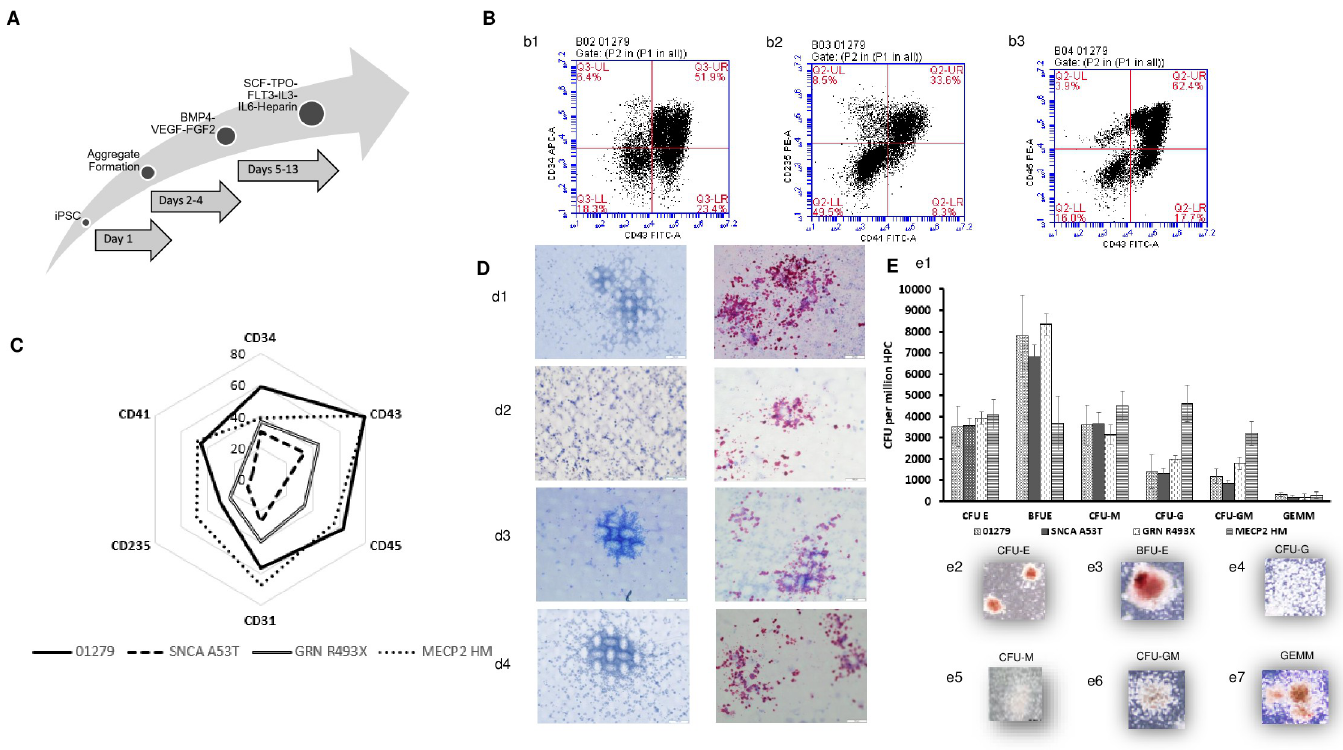
Fig 2. Generation and characterization of HPCs from isogenic iPSCs for disease modelling. (A) A schematic representation of the differentiation process from iPSC to HPC with the timeline and cytokines utilized throughout the process. (B) Representative flow cytometry dot plots for the HPCs’ (b1) lymphoid, (b2) erythroid, and (b3) myeloid potential from 01279 iPSCs. (C) Quantification of HPC purity was confirmed by detection of, CD34, CD43, CD41, CD235a, and CD45 expression on HPCs derived from 01279, SNCA A53T, GRN R493X, and MECP2 HM is depicted. (D) Megakaryocytes/proplatelets stained using MegaCult-C kit. HPCs were plated in collagen-based assay (MegaCult) and to generate megakaryocytes capable of shedding pro-platelets. The emerging megakaryocytes were stained for the presence of CD41 or a matched isotype control and the staining was captured by alkaline phosphatase staining. Presence of megakaryocytes/proplatelets was confirmed by detection of glycoprotein IIb/IIIa accompanied by visualization of pink color. Representative isotype and megakaryocytes/proplatelets images captured using 20X magnification, (d1) 01279, (d2) SNCA A53T, (d3) GRN R493X, and (d4) MECP2 HM. (E) (e1) Multipotency of HPC quantified using the serum free methocult Colony Forming Unit (CFU) assay. The presence of erythroid (CFU-E/BFU-E), myeloid (CFU-M), granulocyte (CFU-G), granulocyte-macrophage (CFU-GM), and multipotent granulocyte- erythroid-macrophage-megakaryocyte (CFU-GEMM) were scored manually and the graphs represent average ± SE for each line. The graph depicts CFU from 01279 (n = 32 ± SE), SNCA A53T (n = 6 ± SE), GRN R493X (n = 6 ± SE), and MECP2 HM (n = 6 ± SE). A representation of emerging CFU colonies, CFU-E (e2), BFU-E (e3), CFU-G (e4), CFU-M (e5), CFU-GM (e6), and GEMM (e7).